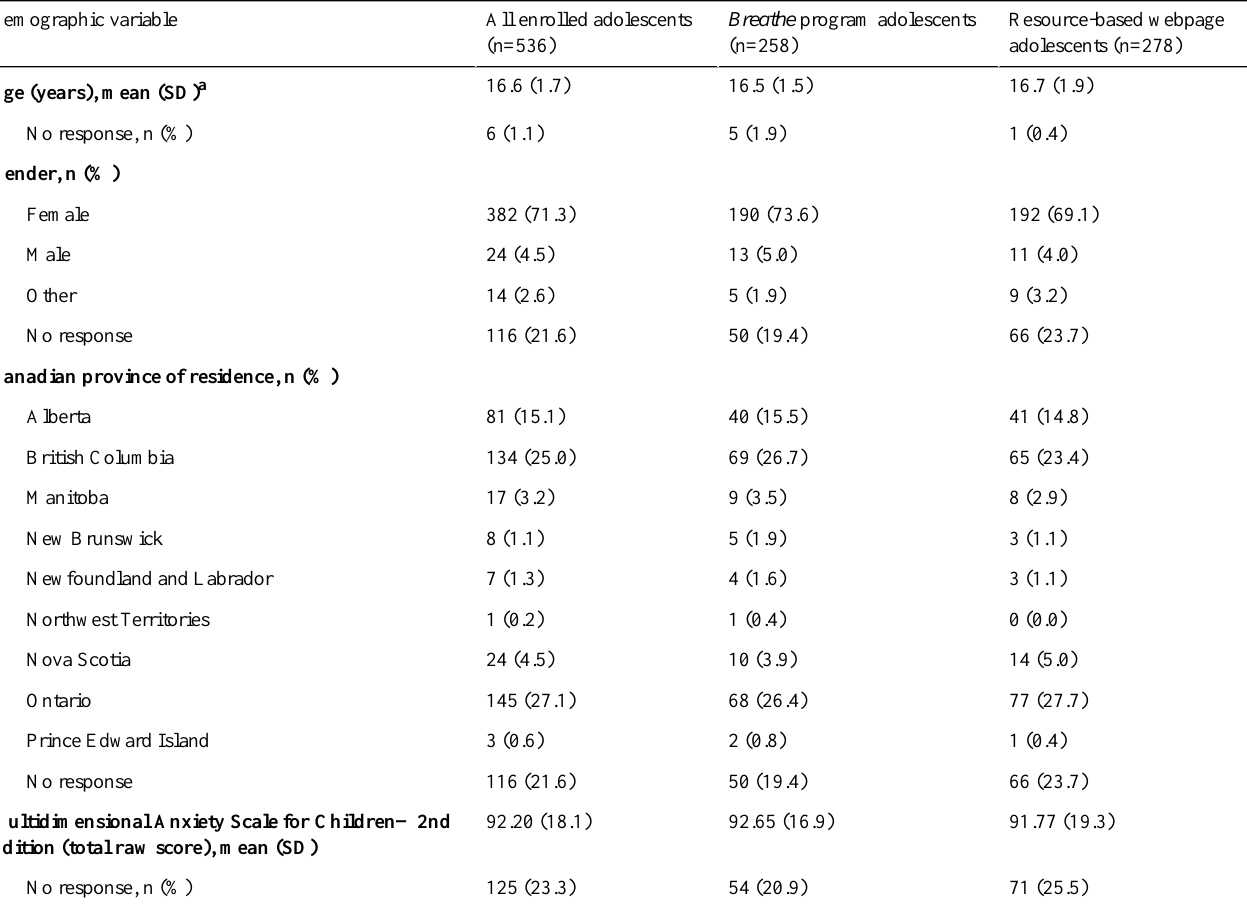
Table 3. Preintervention demographics of enrolled adolescents organized by total adolescents enrolled and total adolescents assigned to each intervention.